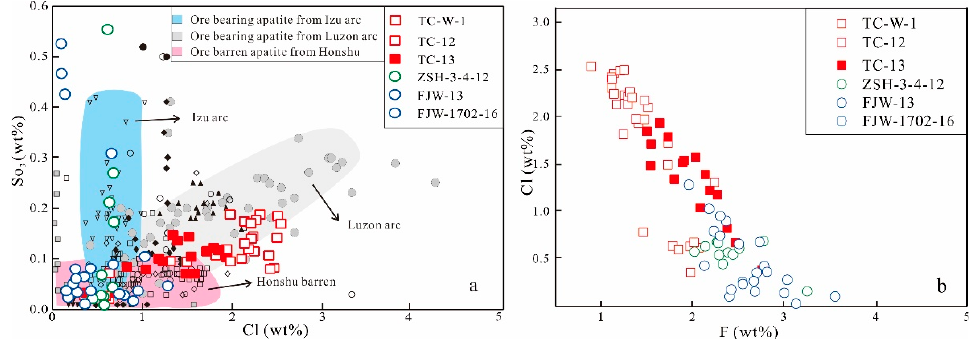
Figure 9. The Dexing porphyries and wall rock apatite trace element ratios. ( a ) SO 3 vs. Cl distribution in apatite. The Luzon arc from the Philippines and the Izu Bonin arc are related with deposits, and are distinct from Honshu from northeastern Japan that is barren. Modified from Imai et al. [75]; ( b ) F vs. Cl contents’ distribution in apatite from the Dexing deposit.